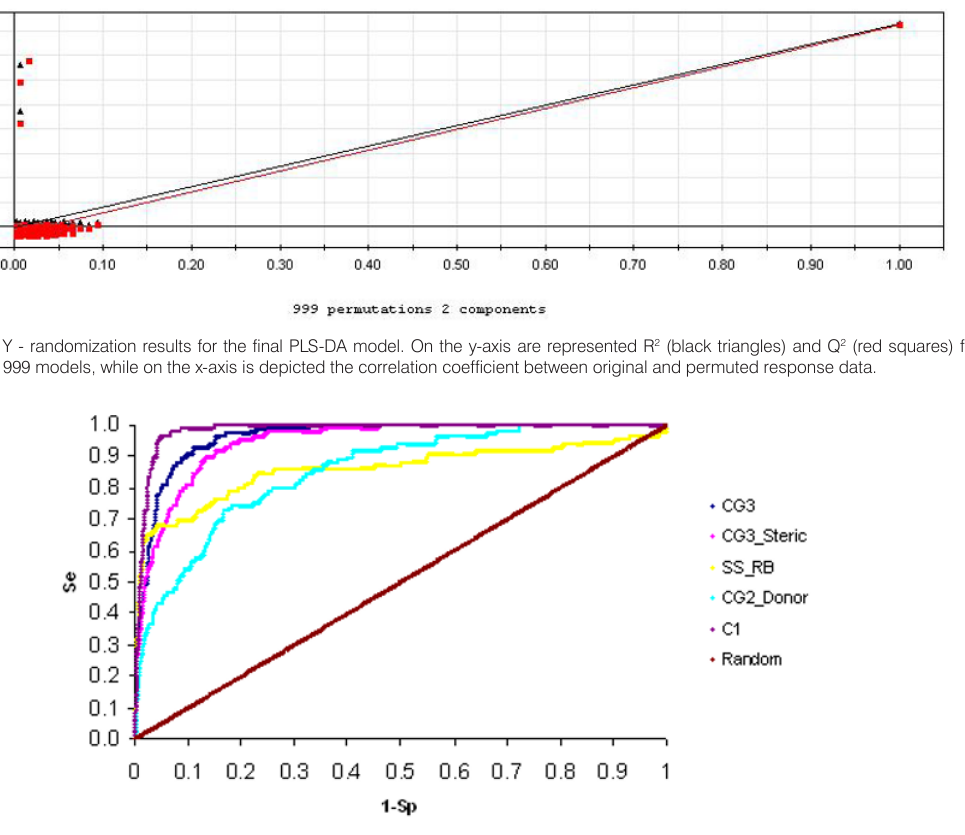
Figure 5. ROC plot of the of the best classical scoring functions (CG3) and the selected energetic terms (CG3_Steric, SS _RB, CG2_Donor) evaluated in the rescoring protocol considering the AUC values